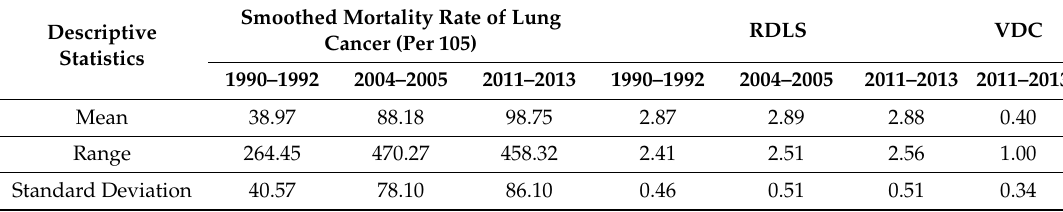
Table 1. Descriptive statistics of the village-level mortality rate and topographic factors in